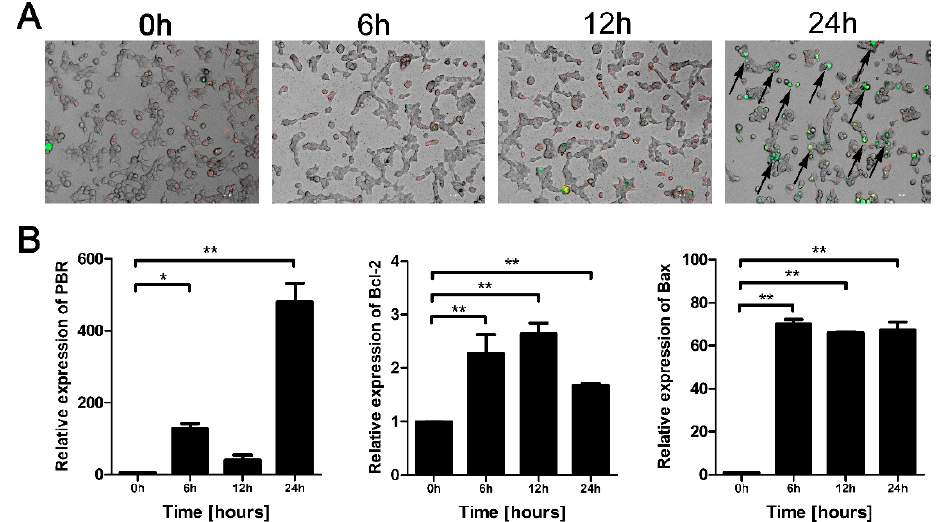
Figure 4. Eno induces increased permeability of the mitochondrial membrane. 293T cells were treated with Eno and incubated for 0 h, 6 h, 12 h, and 24 h; then, the mitochondrial membrane potential and expression of PTPs were analyzed. ( A ) Mitochondrial membrane potential marker JC-1 was detected. When the mitochondrial membrane potential is high, JC-1 concentrates in the mitochondrial matrix and forms a complex with Mito-Tracker Red CMXRos which produces red fluorescence. In contrast, JC-1 does not concentrate in mitochondria when the membrane potential is at a low level, represented by green fluorescence. (Scale bar, 200 µm) ( B ) qPCR to determine the relative transcriptional levels of PTP-encoding genes (including PBR , Bcl-2, and Bax ) of Eno-treated cells. (PTPs: permeability transition pore proteins) (*, p < 0.05; **, p < 0.01)